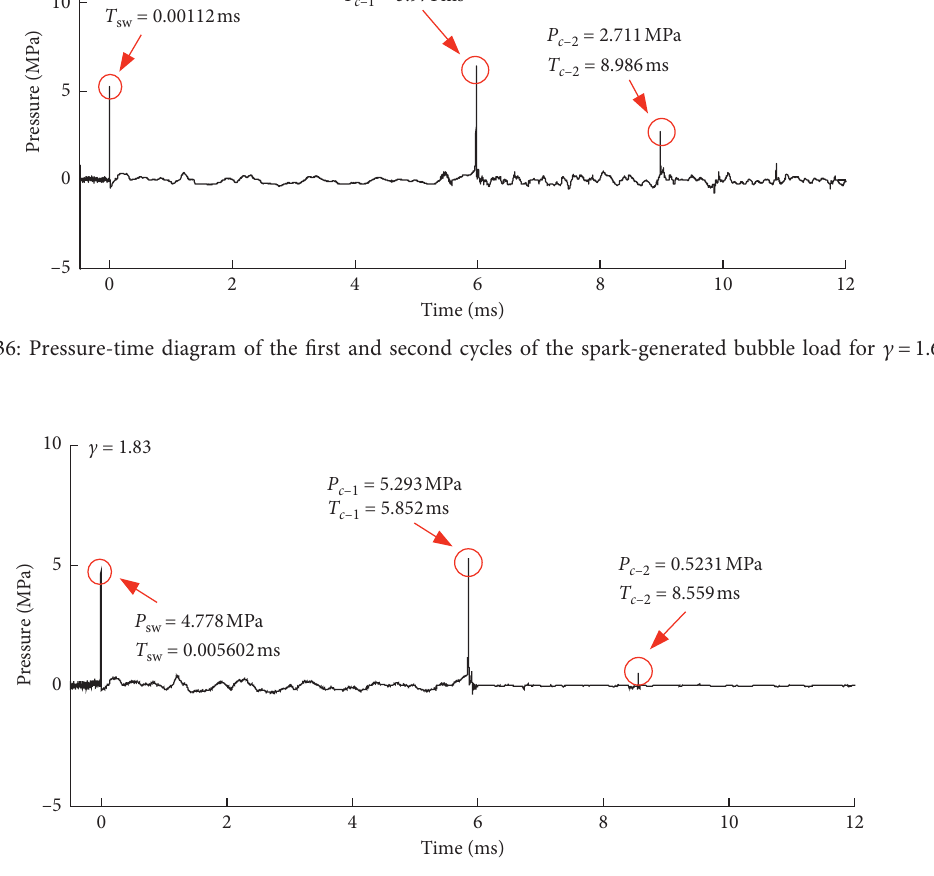
Figure 37: Pressure-time diagram of the first and second cycles of the spark-generated bubble load for c � 1.83. γ = 2.00